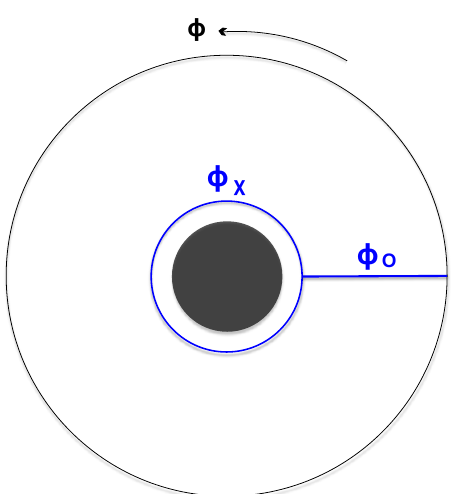
Figure 1 . Geodesic approximation to the one-loop contribution to the one-point function of (cid:30) O . A constant time slice of the BTZ metric is depicted. The (cid:30) (cid:31) particle wraps the horizon and meets the (cid:30) O particle emanating from the boundary at a cubic vertex. If the geodesic worldlines are replaced by propagators and the cubic vertex is integrated over spacetime, this becomes a full-(cid:13)edged one- loop Witten